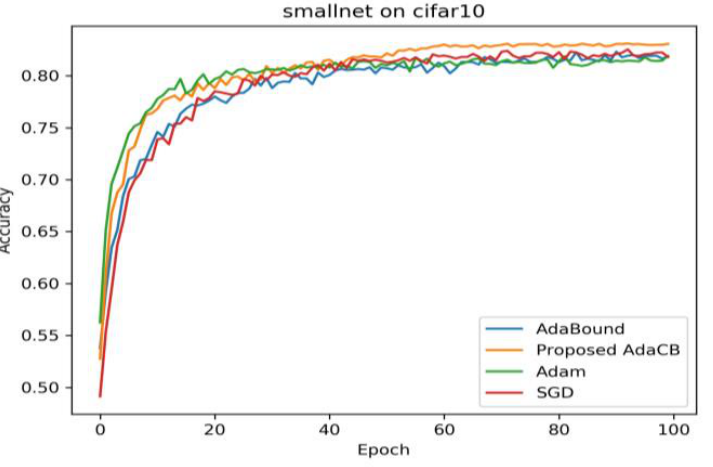
Figure 2. The learning curve of testing accuracy on CIFAR10 under Smallnet.